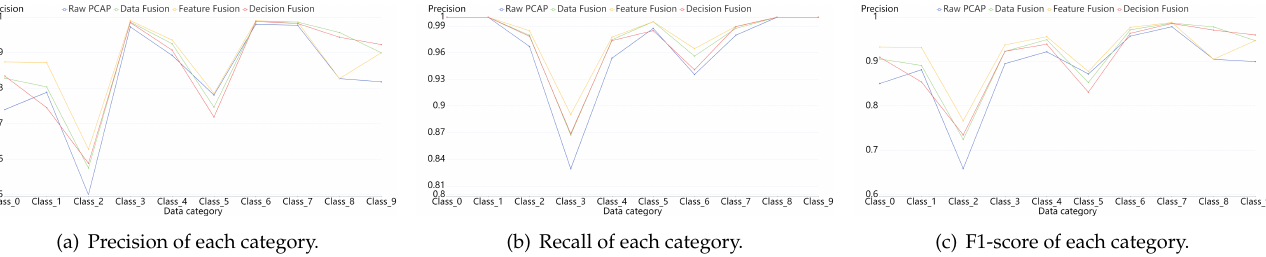
Figure 12. Classification results of each category on dataset NB15. They are composed of Precision, Recall and F1-score, which are calculated by a simple model with PCAP data, data fusion model, feature fusion model and decision fusion